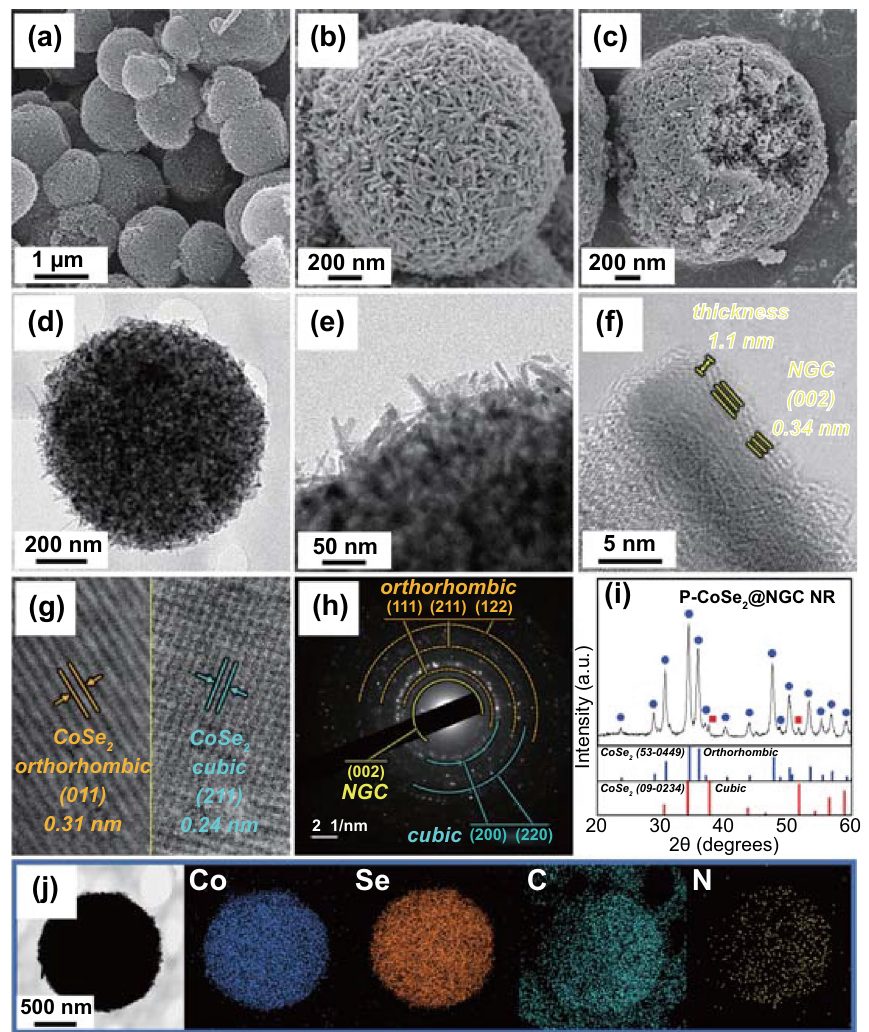
Fig. 2 Morphologies, SAED, XRD patterns, and elemental mapping images of the P-CoSe 2 @NGC NR microspheres by spray pyrolysis and subsequent selenization at 350 °C: a, b FE-SEM images, c fractured sphere’s FE-SEM image, d‑f TEM images, g HR-TEM image, h SAED pat- tern, i XRD pattern, and j elemental mapping